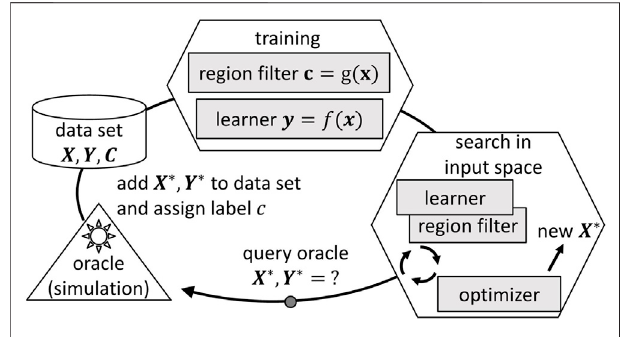
FIGURE 2 | Iterative procedure of membership query synthesis (cf. Settles (2012)) including an extension to avoid sampling in regions out of scope. The class labels of the data points are represented by C i ∈ (0,